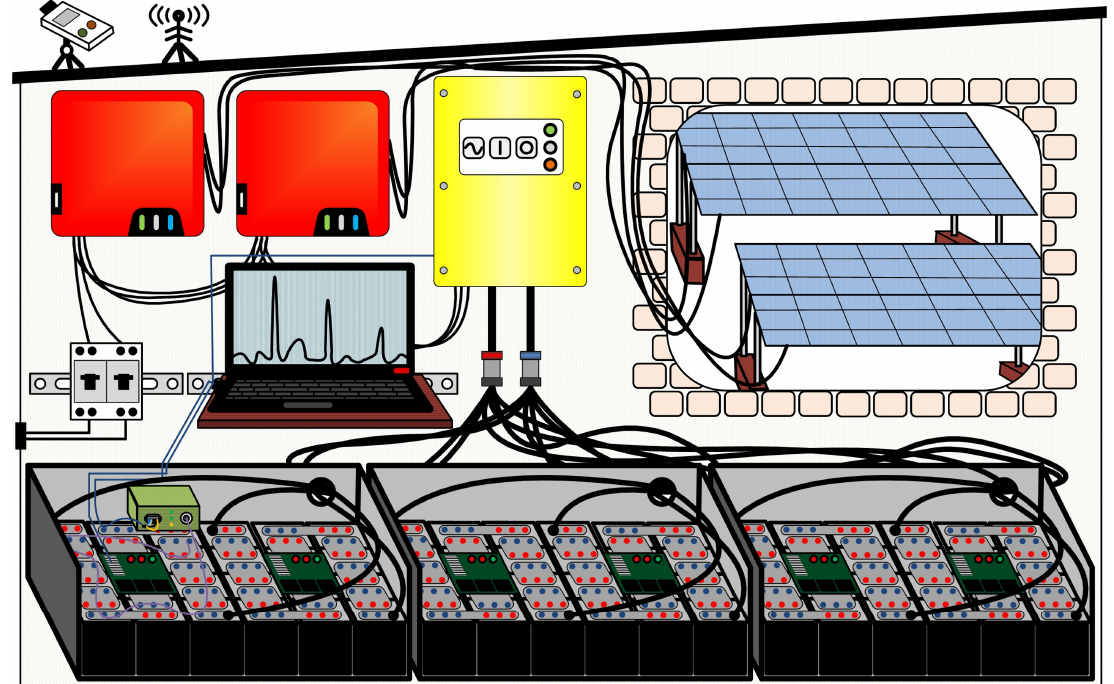
Figure 1. Schematic representation of the energy system structure; each of the six battery cell strings is monitored by a battery management system. One string is additionally equipped with fiber-optical sensors. The battery is connected on the DC side to the off-grid converter. The DC produced by the photovoltaic system is transformed by the two inverters, which frequency-controlled feed the power grid generated by the off-grid converter.